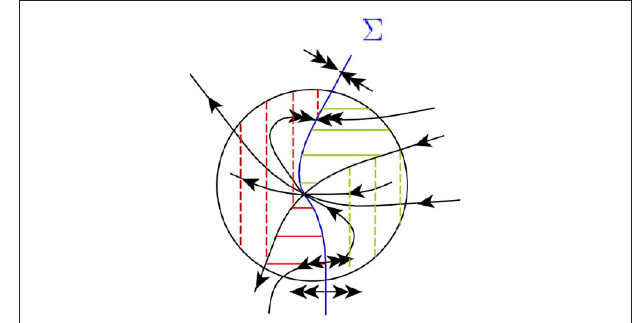
FIGURE 5 | Dynamics around a simple singular equilibrium: the case of a folded node. The solid green and red lines mark the incoming and outgoing sectors, respectively. The dashed green and red lines mark the stable and unstable sectors,